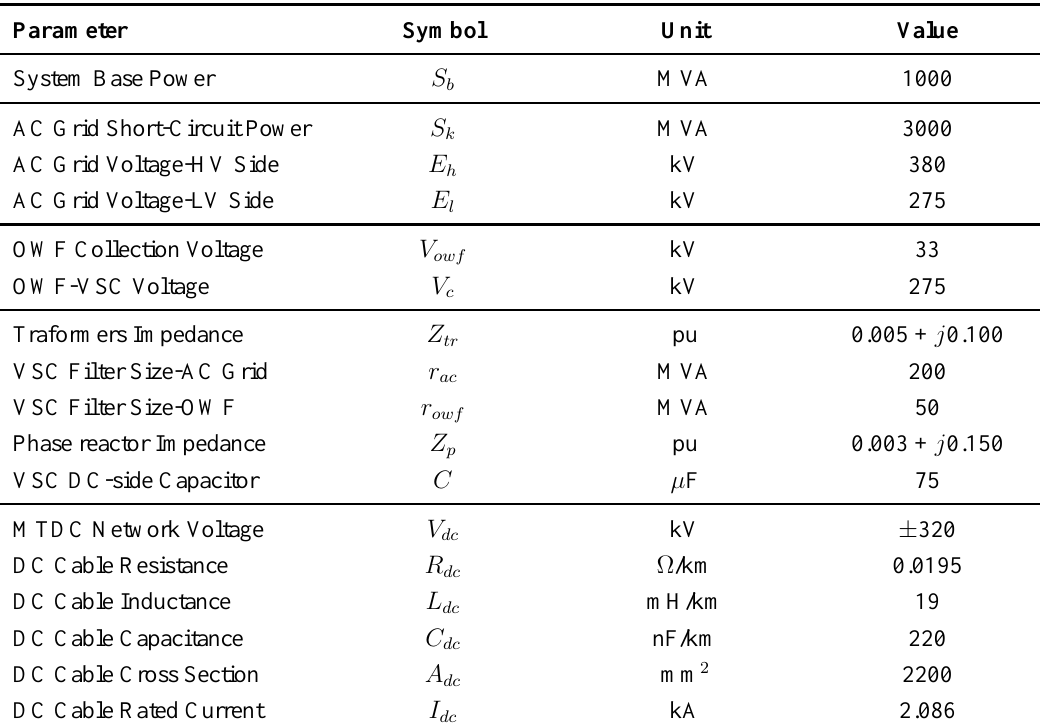
Table 2. MTDC network